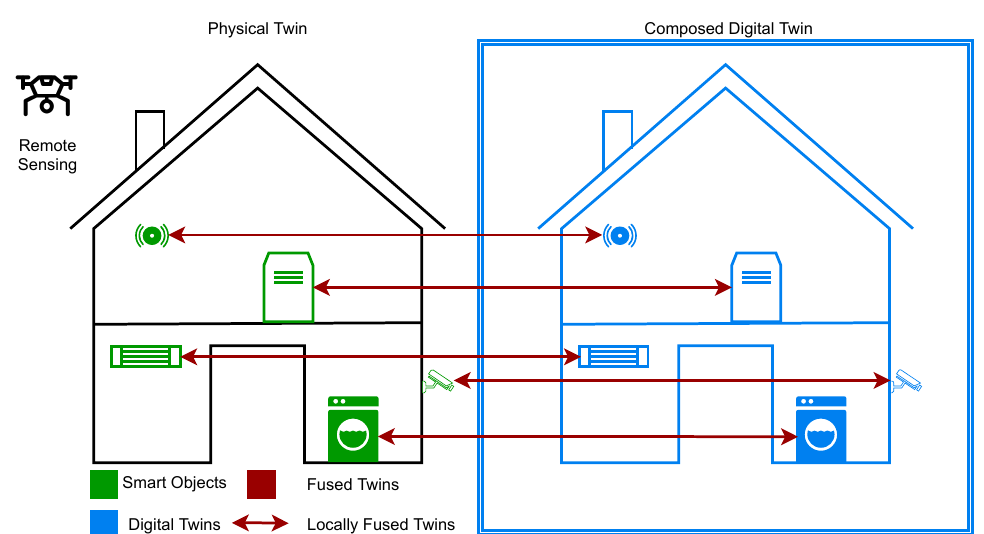
Figure 9. Example Composition of DTs. Multiple Smart Objects (SOs) and their DTs are composed into a DT of a Household. Remote sensing provides the external context to the building. Locally, FTs (SOs) provide physical user interfaces, enabling end users to directly interact with the DT in a natural way. Generated with http://draw.io.